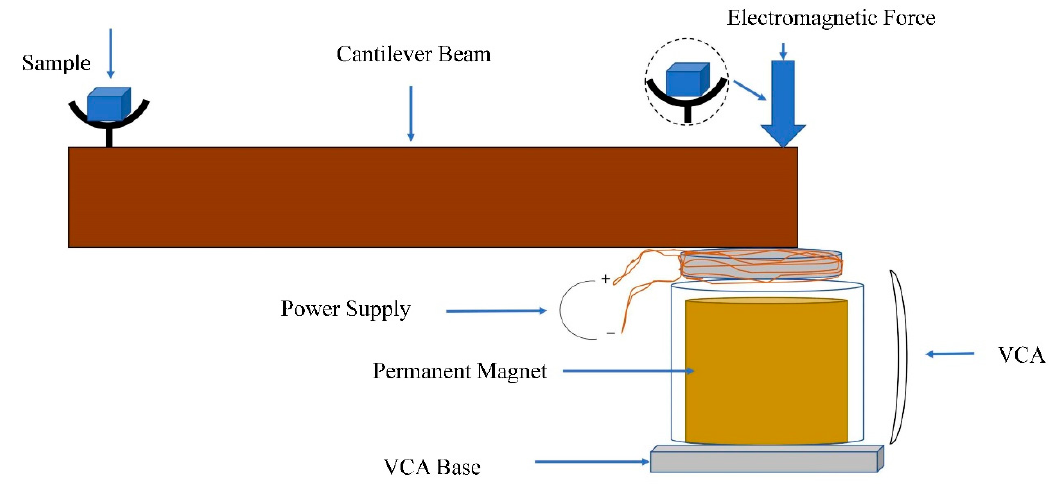
Figure 1. Schematic outlines of electromagnetic force compensation (EMFC) balance-type scale.